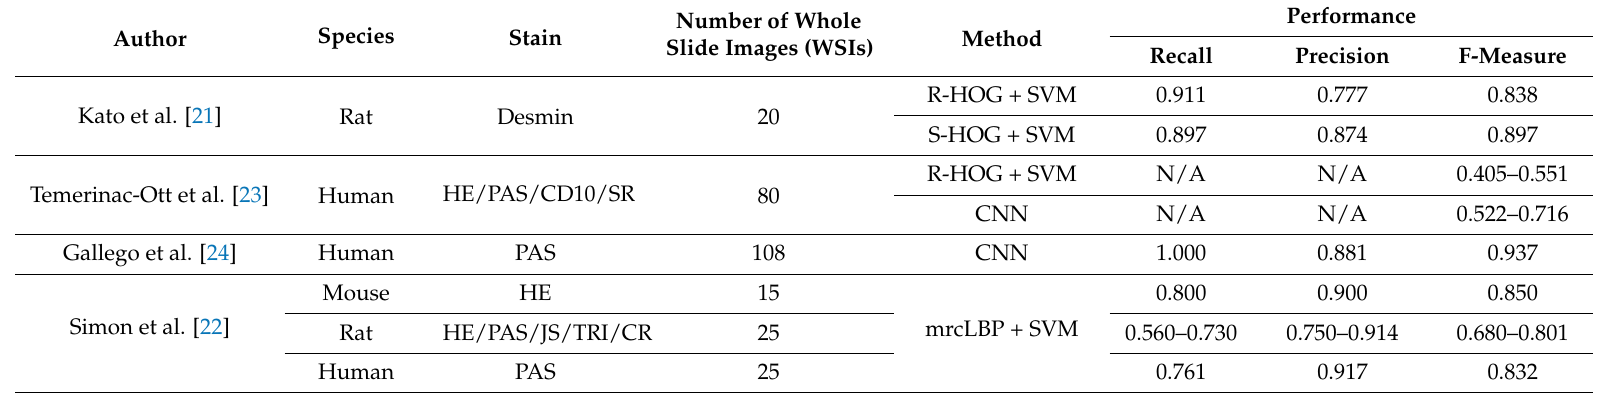
Table 1. Summary of previous